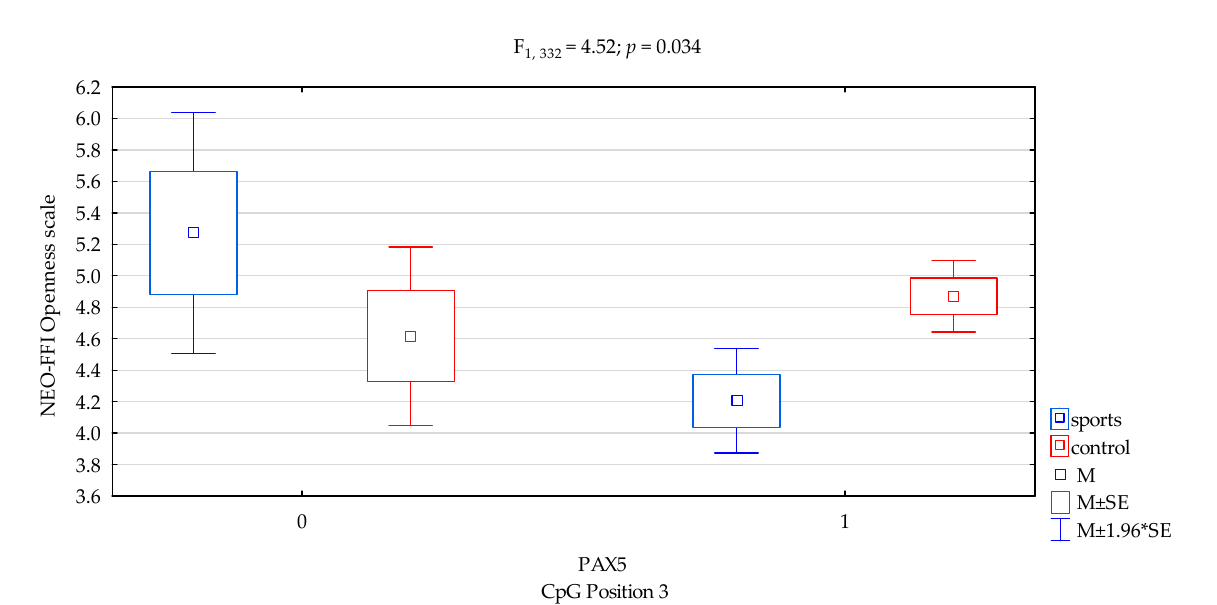
Figure 1. Interaction between sports subjects/control and DAT1 PAX5 CpG sites 3 and NEO FFI Openness scale. Methylation status: yes—1, no—0. M—mean, M ± SE—mean ± standard error, M ± 1.96*SE—mean ± s1.96*standard error. Table 4. Post hoc analysis of interactions between sports subjects/control and DAT1 PAX5 CpG sites 3, 13, 22, 33 and NEO FFI scale.